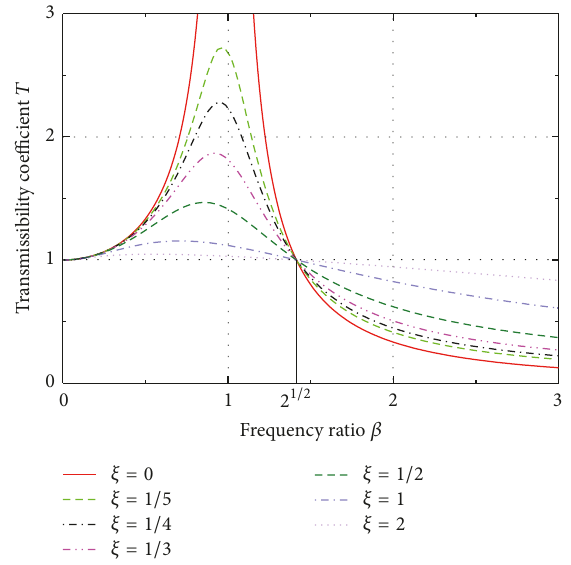
Figure 2: Transmissibility